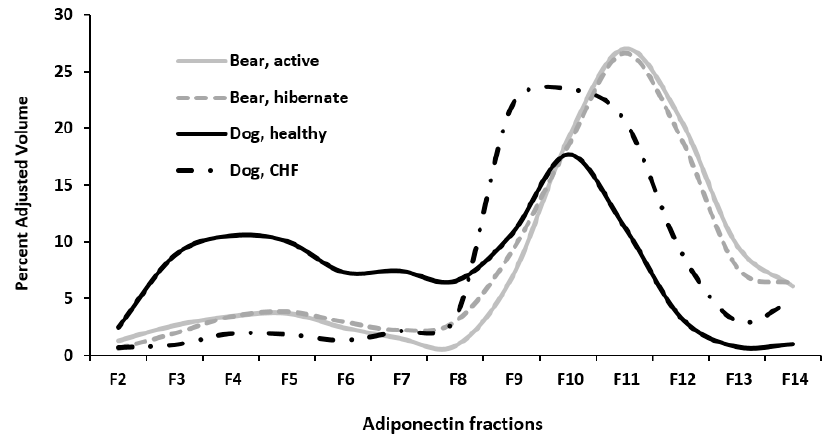
Figure 5. Band density targeting myocardial adiponectin was determined for fractions obtained from sucrose gradients and plotted for each group. Fractions 3–6 contain the LMW isoforms of adiponectin and fractions 9–12 contain the HMW isoforms. All bears expressed a higher concentration of HMW isoforms relative to LMW isoforms of adiponectin, and no significant difference was found between the active ( n = 6) and hibernating bears ( n = 6). Healthy dogs ( n = 6) expressed similar myocardial concentrations of LMW and HMW adiponectin isoforms, whereas CHF dogs ( n = 6) expressed significantly greater concentrations of HMW relative to LMW adiponectin.